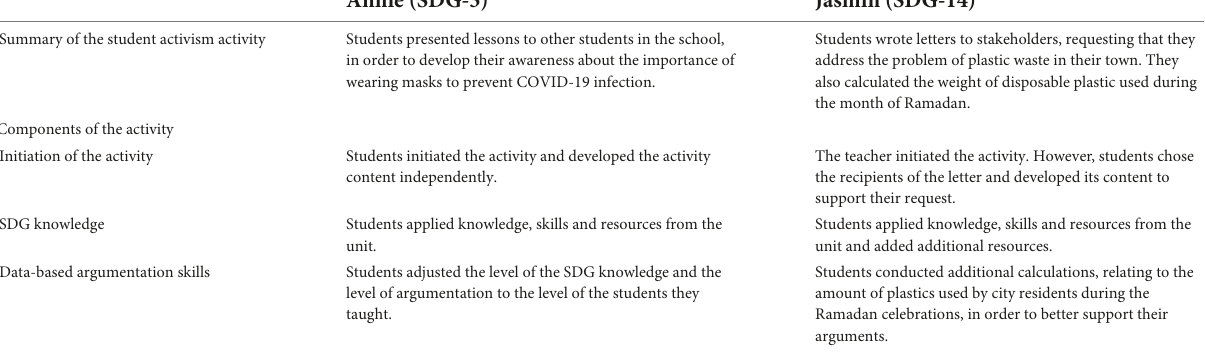
TABLE 2 Analysis of the components of the student activism